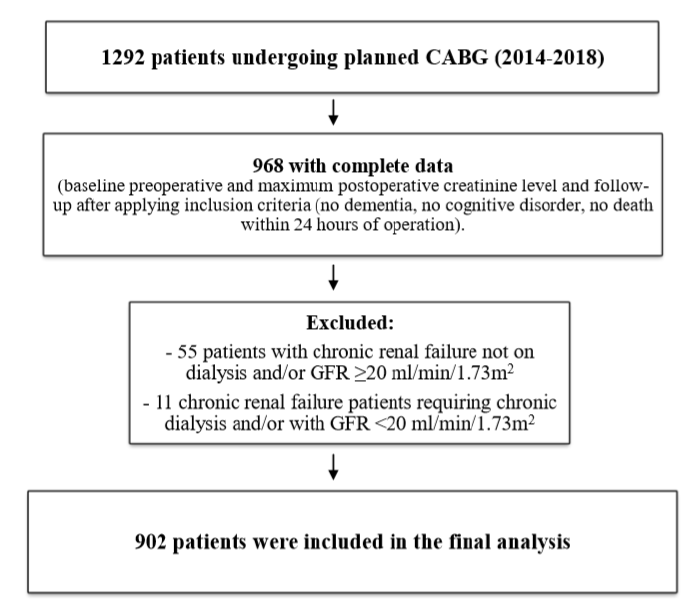
Figure 1. Study flowchart.